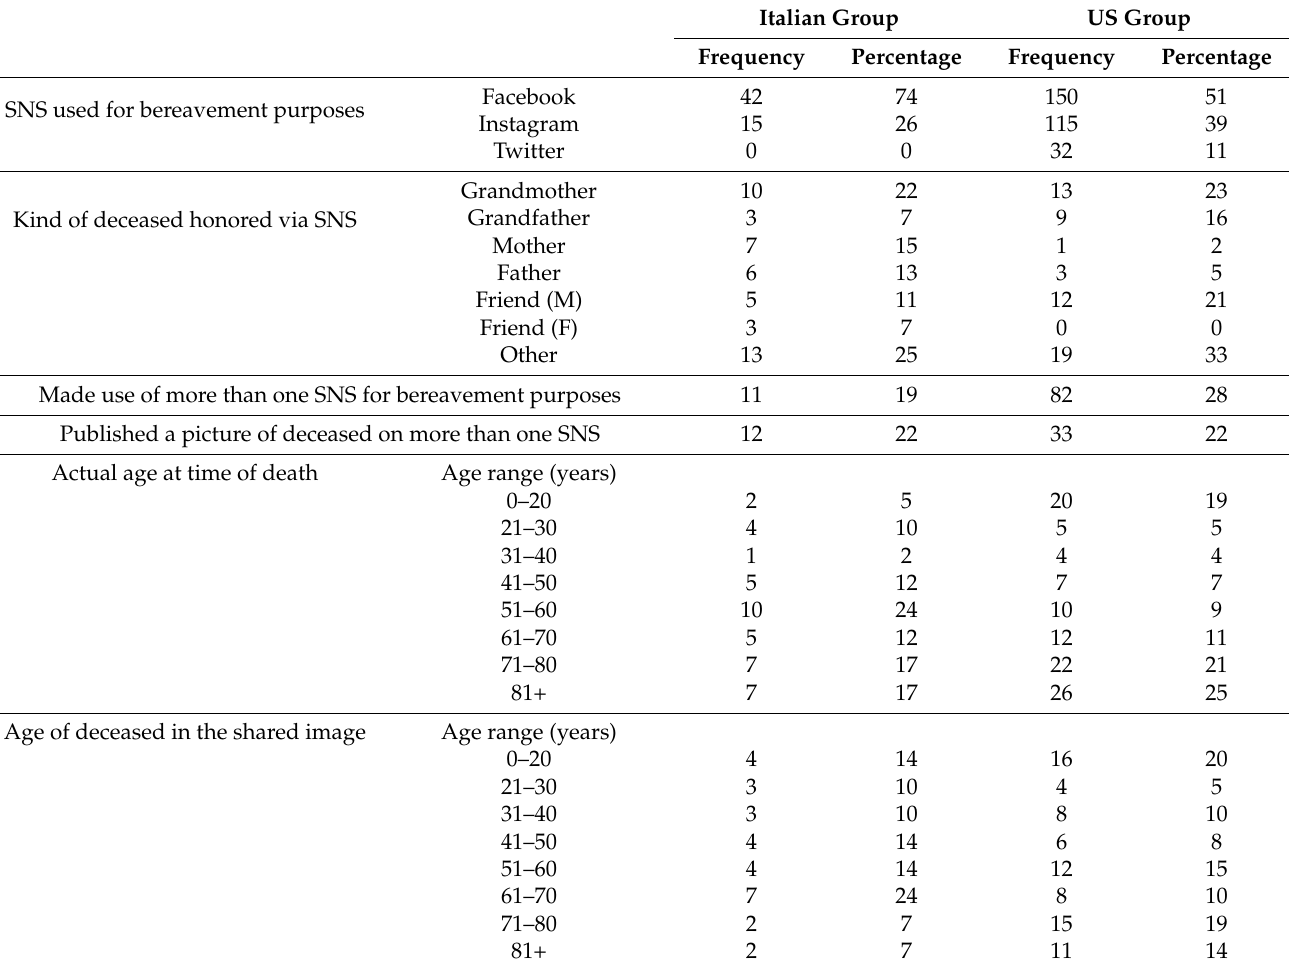
Table 2. Percentages of different uses of SNS in the Italian and US